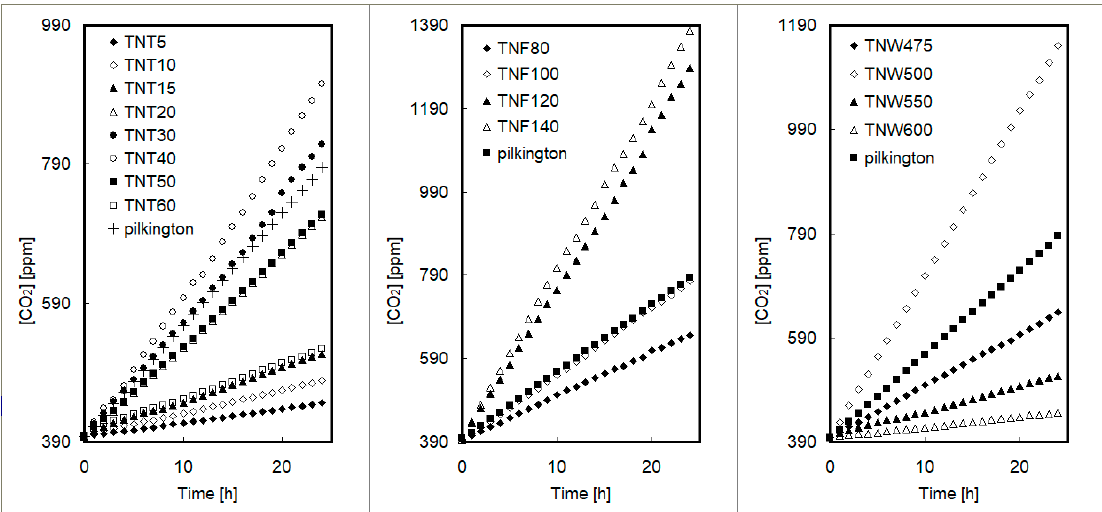
Figure 8. CO 2 concentration-time data for acetone photodegradation for titania nanotubes (TNT), nanofibers (TNF), and nanowires (TNW).